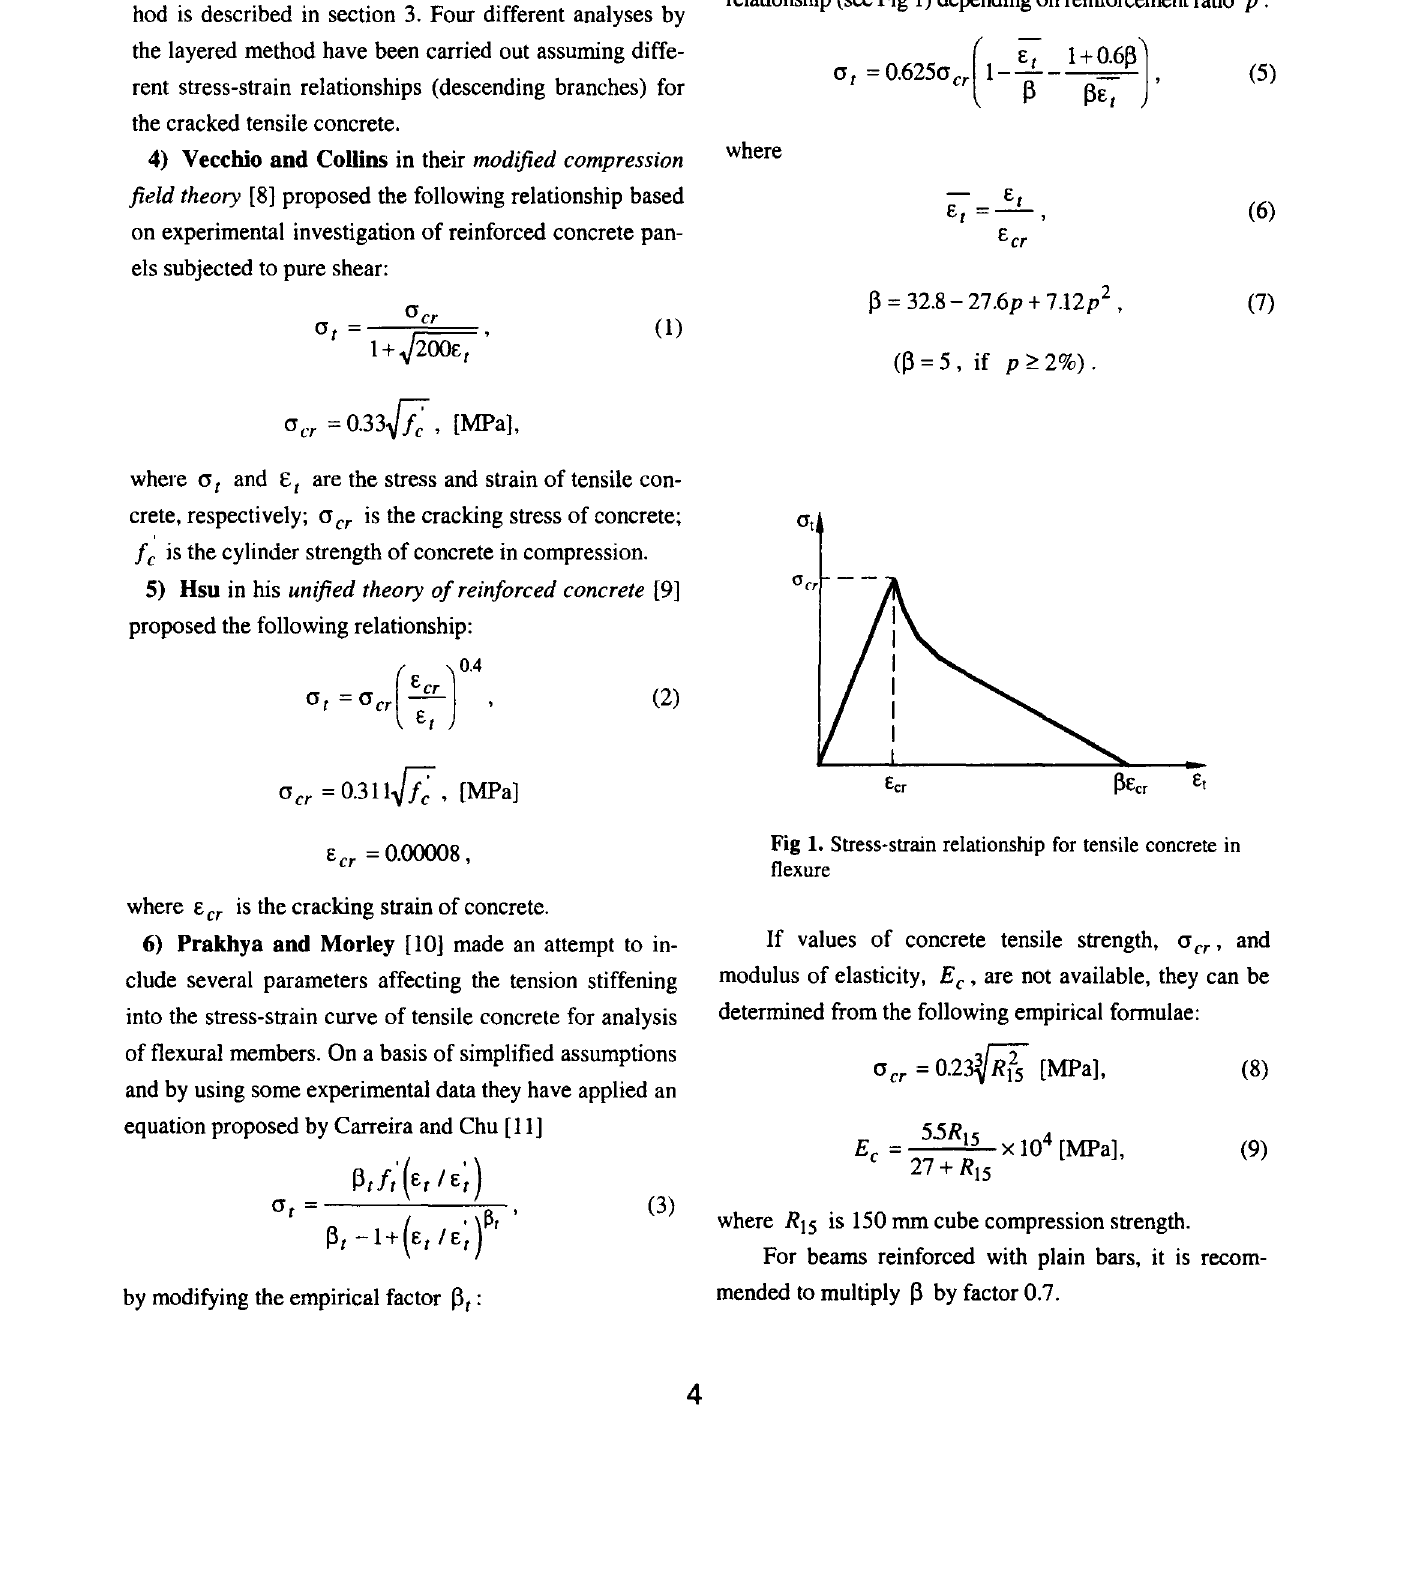
Fig 1. Stress-strain relationship for tensile concrete in